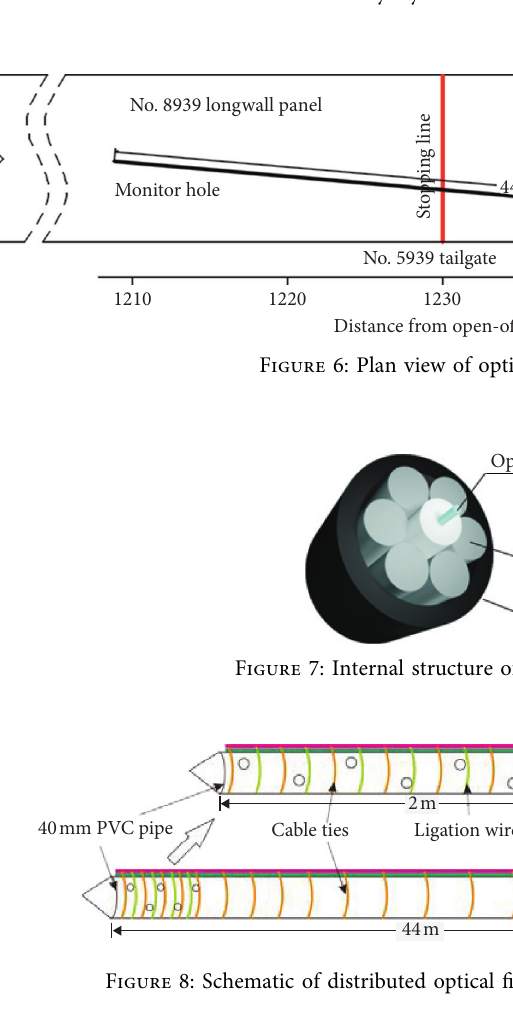
Figure 5: Roadway layout of no. 8939 longwall panel.